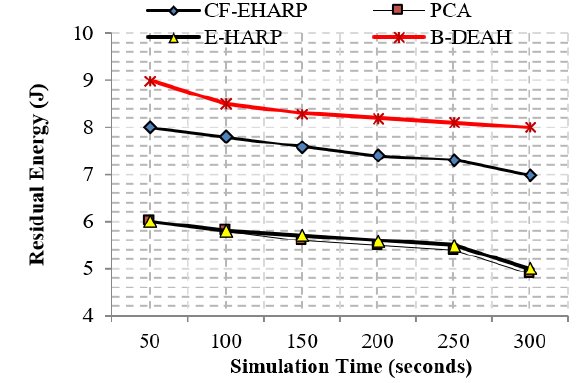
Figure 16. Residual energy vs. simulation time (s) (emergency packets).